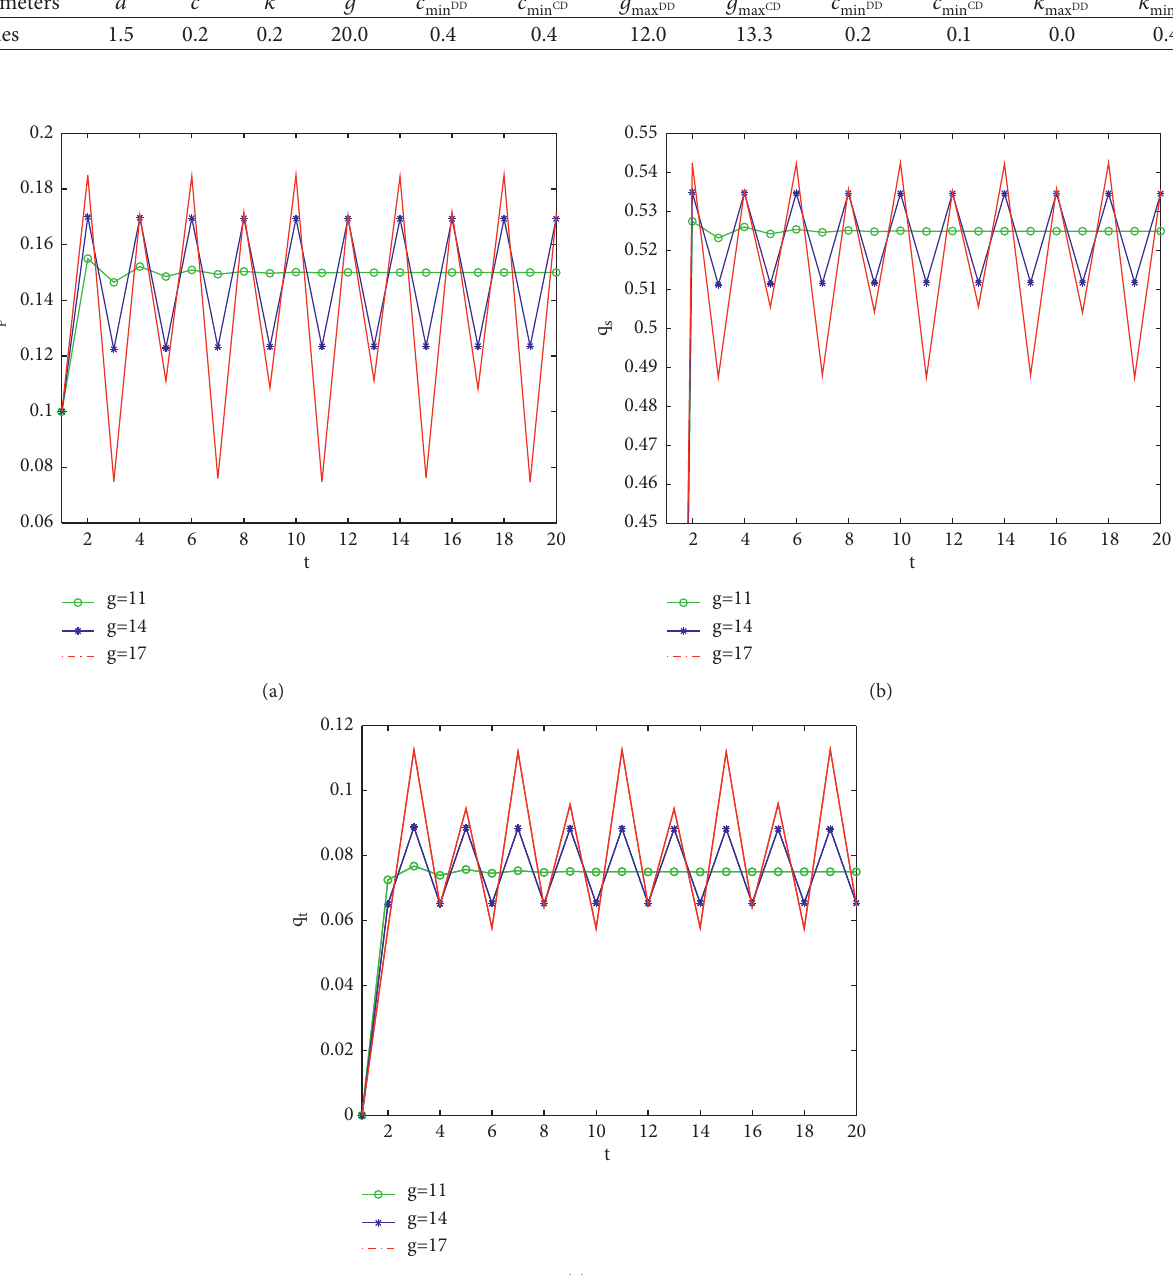
q q p , (b) s , and (c) t